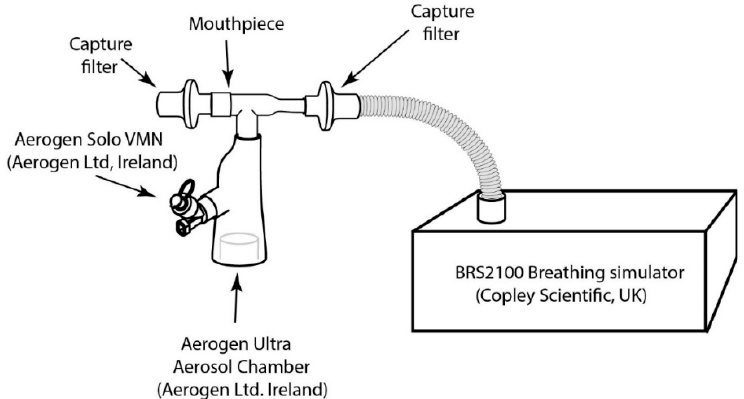
Figure 1. Inhaled dose assessment of nebulized ATRA-loaded PLGA NPs experiment set up.